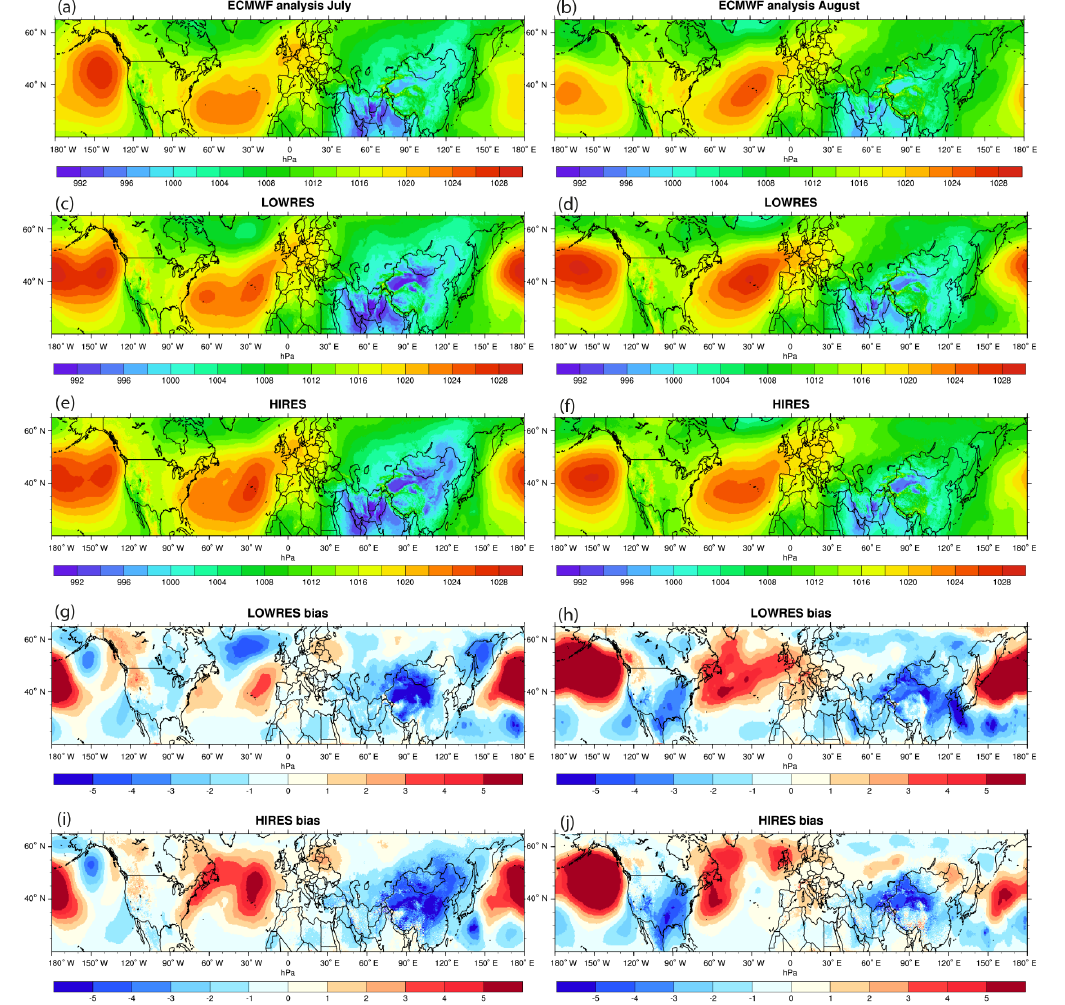
Figure 5. Average mean sea level pressure and mean difference between the WRF simulations and ECMWF analysis at the 12:00UTC time steps for July 2013 and August 2013. The first row shows the ECMWF analysis (a, b) followed by the LOWRES simulation (c, d) and the HIRES simulation (e, f) . The two lowermost rows show the mean bias for the LOWRES (g, h) and the HIRES simulations (i, j) compared to the ECMWF analysis for the two different